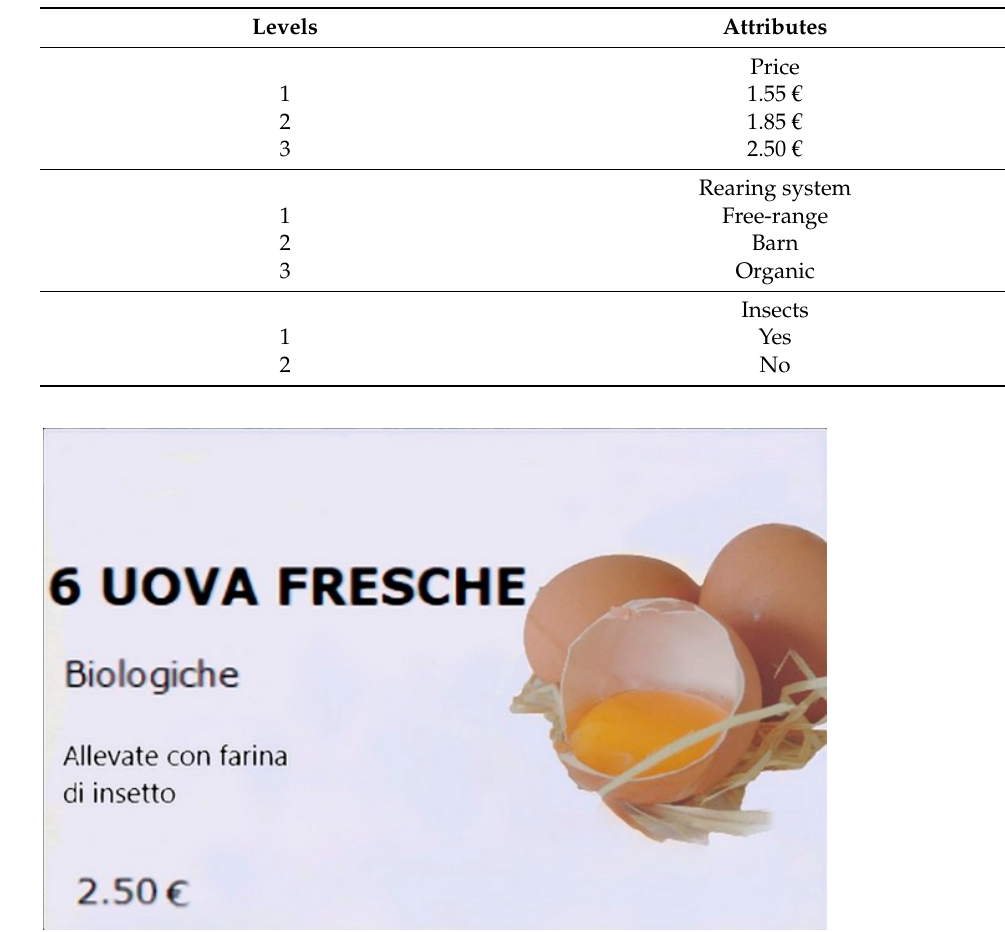
Figure 1. Example of a card presented in the online